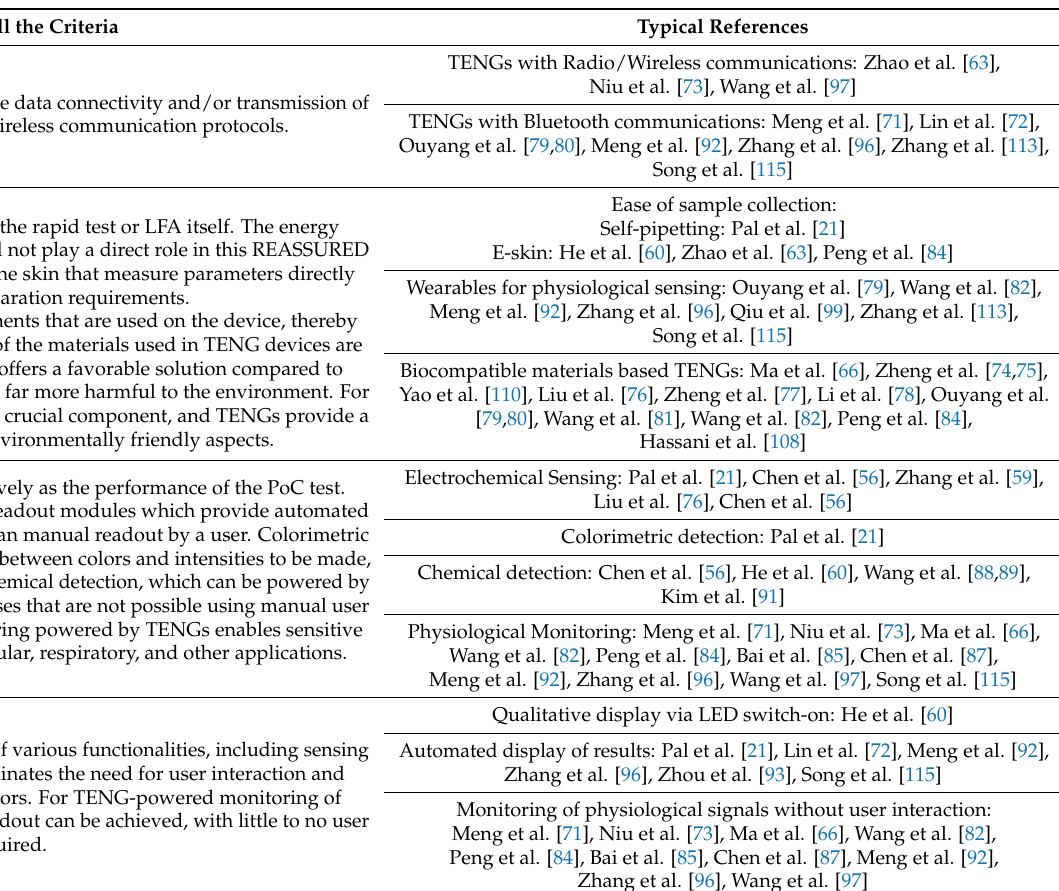
Table 2. REASSURED principles and how existing TENG solutions contribute to the fulfillment of these